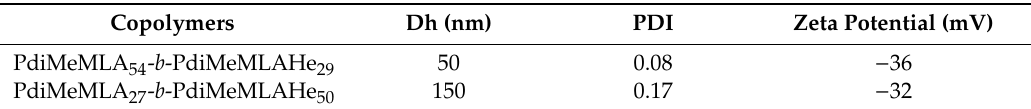
Table 5. Characteristics of NPs suspension prepared by nanoprecipitation of amphiphilic block copolymers.